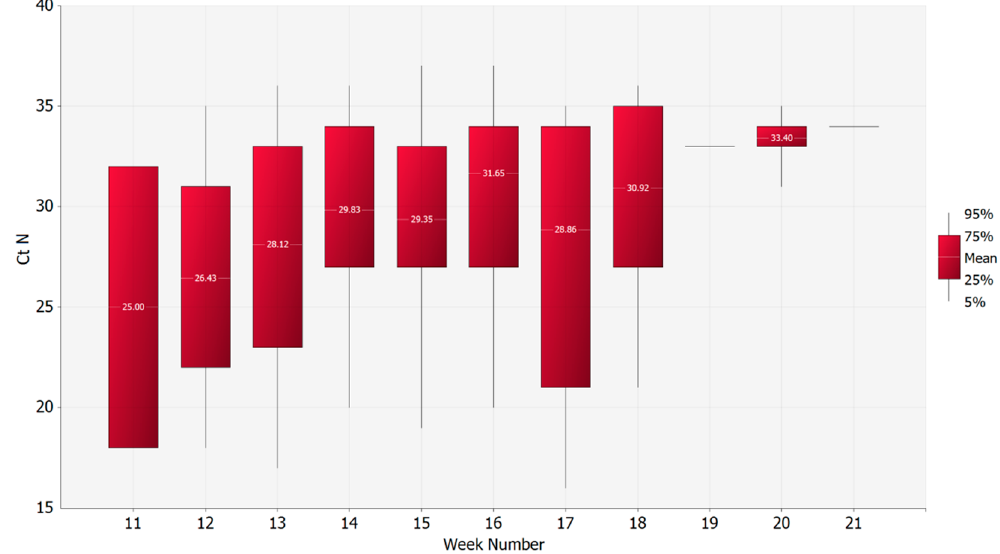
Figure 3. Trend of C T N gene mean values of the first positive swab per patient by week of sampling.